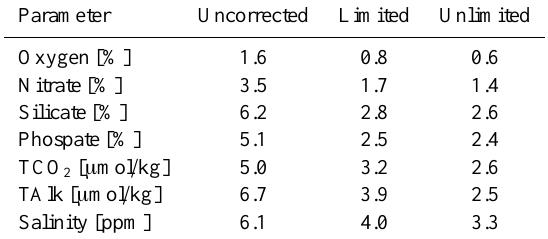
Table 3. The internal consistency of the data set expressed as the weighted mean of the absolute o ff sets for all crossovers in CA- RINA. Various levels of consistency are acquired by applying vary- ing corrections to the dataset: Uncorrected, before any adjustments are applied; Limited, no adjustments smaller than the cut-o ff limit (see Table 2) are applied; Unlimited, all corrections suggested by the inversion are applied. The statistics are determined by the cnaX routines using all crossovers from the complete CARINA data